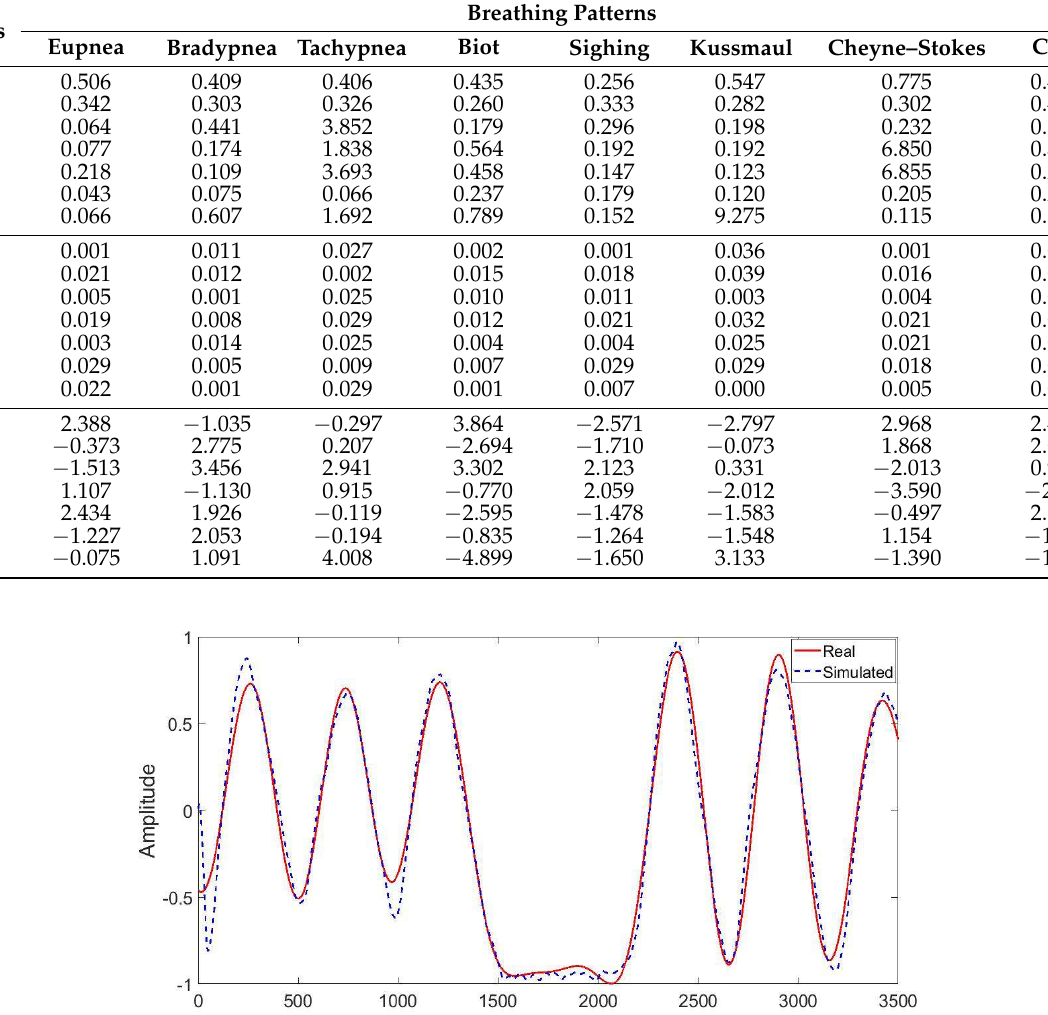
Figure 5. Simulated and real-time Biot breathing.